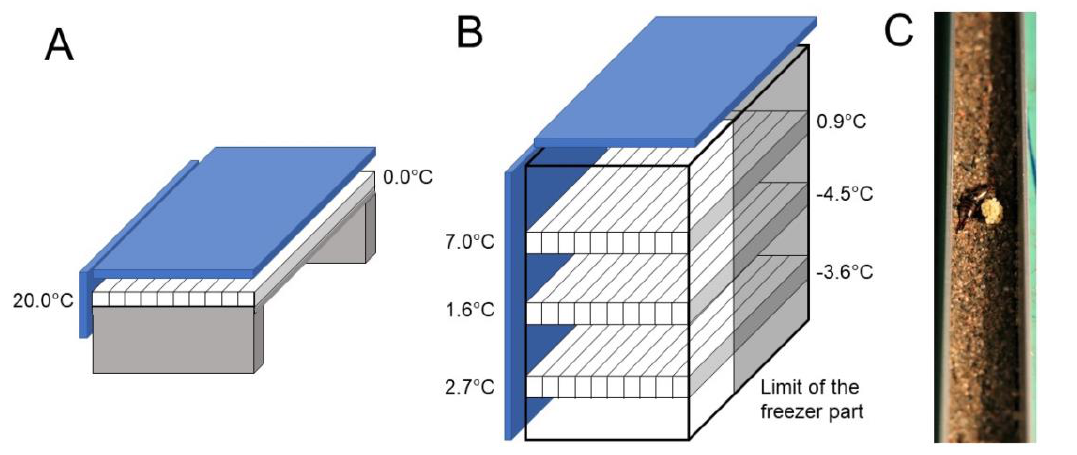
Figure 1 – Schema of the thermal setups used in the experiment. (A) Schema of one of the two thermoelectric plates with temperatures linearly ranging from 0°C to 20°C and insulated on every side with thick foam (blue) to ensure complete darkness and thermal isolation. Each plate received 16 rails, each containing one female until they laid eggs and then from the 15th week after oviposition until egg hatching. (B) Schema of the homemade climate cabinet build from a small vertical freezer whose door had been removed and the apparatus covered with plywood enclosure (blue=foam) to ensure complete darkness and thermal isolation, and a vertically sliding front door to allow removal. The cabinet was subdivided into three parts to obtain warm (0.9°C to 7.0°C), cold (-4.5°C to 1.6°C) and intermediate (- 3.6°C to 2.7°C) temperature ranges. This cabinet hosted 60 females (20 per temperature range) and